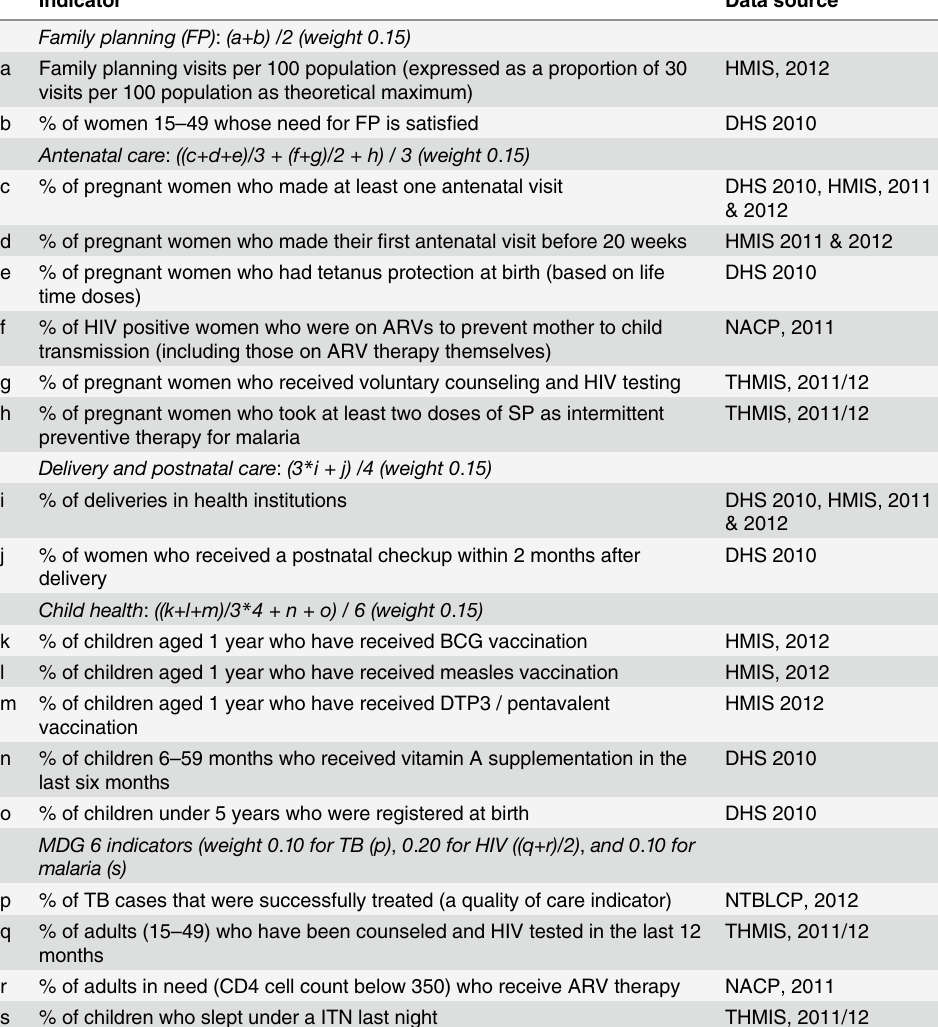
Table 1. Indicators included in the Millennium Development Goals coverage score, with weighting.